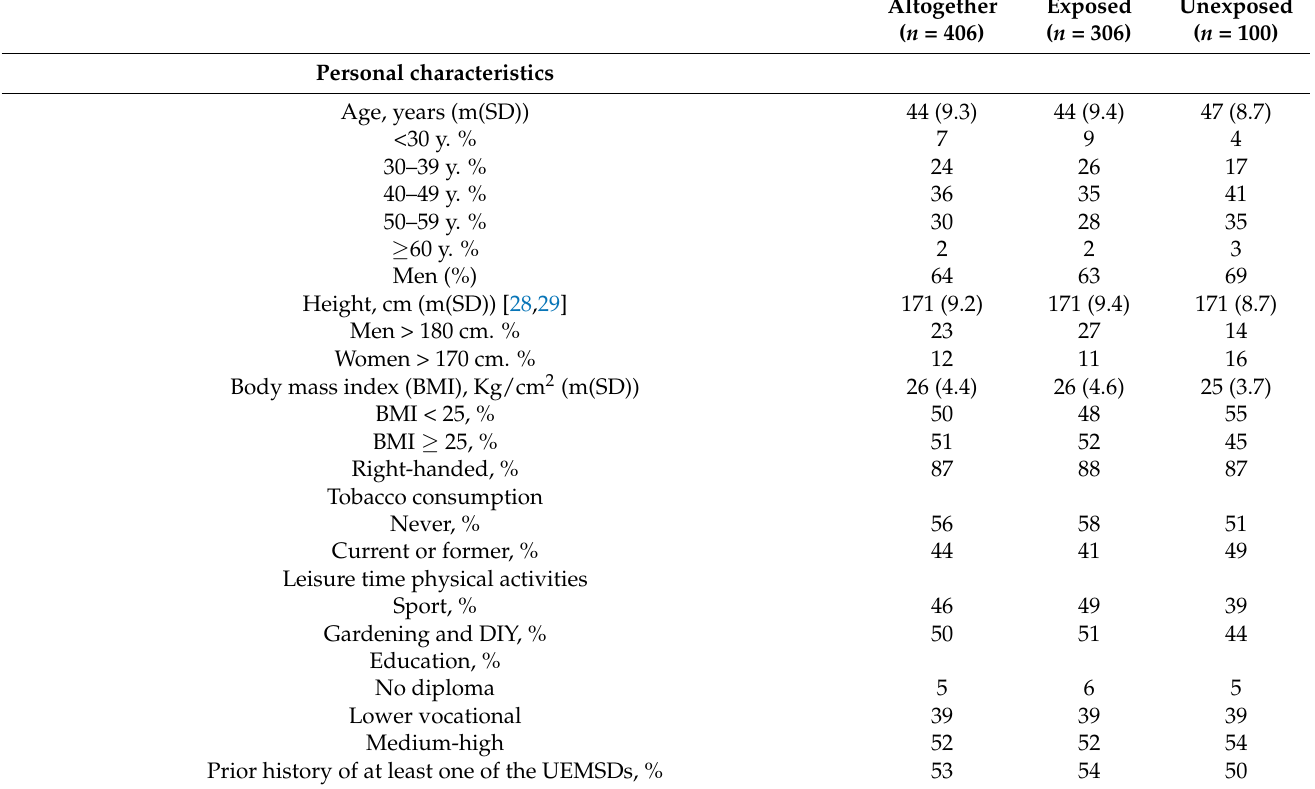
Table 1. Main personal characteristics and occupational factors of the study population exposed to driving light-duty vehicles and unexposed subjects. Abbreviations: LDV: light-duty vehicle; UEMSDs: upper extremity musculoskeletal disorders; LBP: low back pain; m (SD): mean (standard